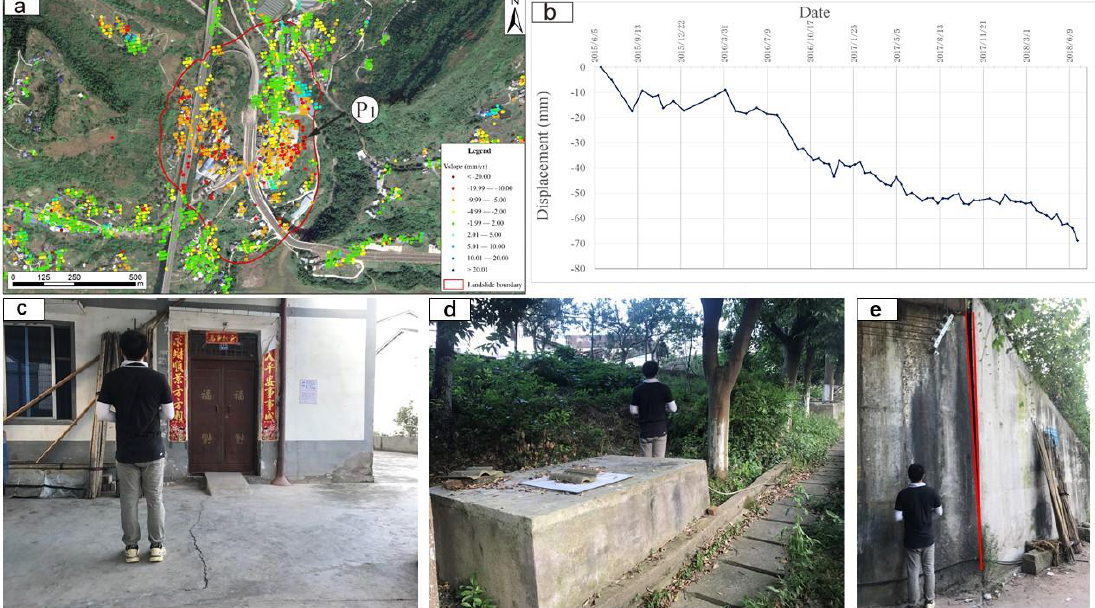
Figure 7. ( a ) PSInSAR deformation rate map of the Dadiping landslide. ( b ) InSAR time-series analysis result of persistent scatters at site P1. ( c ) Cracks observed at the floor of a nearby house. ( d ) Anti-slide piles in front of the highway. ( e ) Crack observed in a nearby slope protection wall.